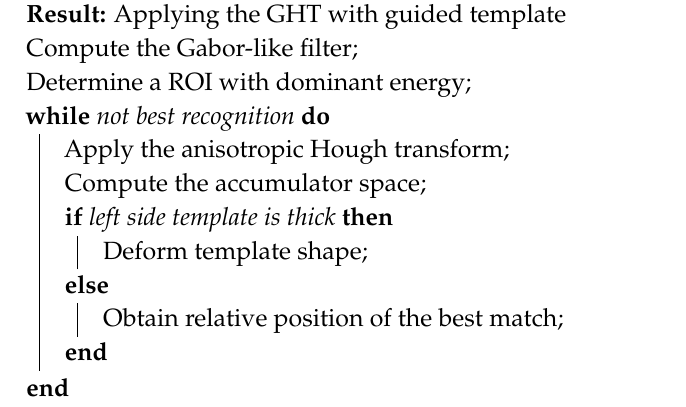
Algorithm 1: GHT marking of the left ventricle.